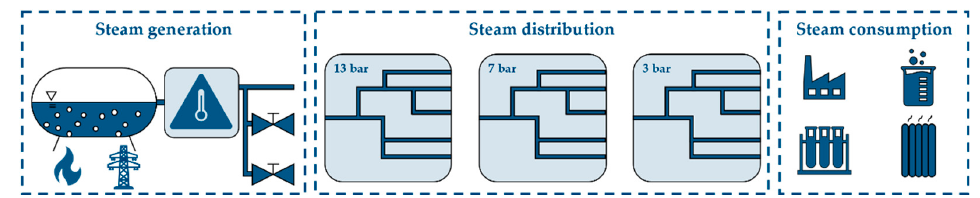
Figure 3. Simplified system topology of the investigated steam supply system.